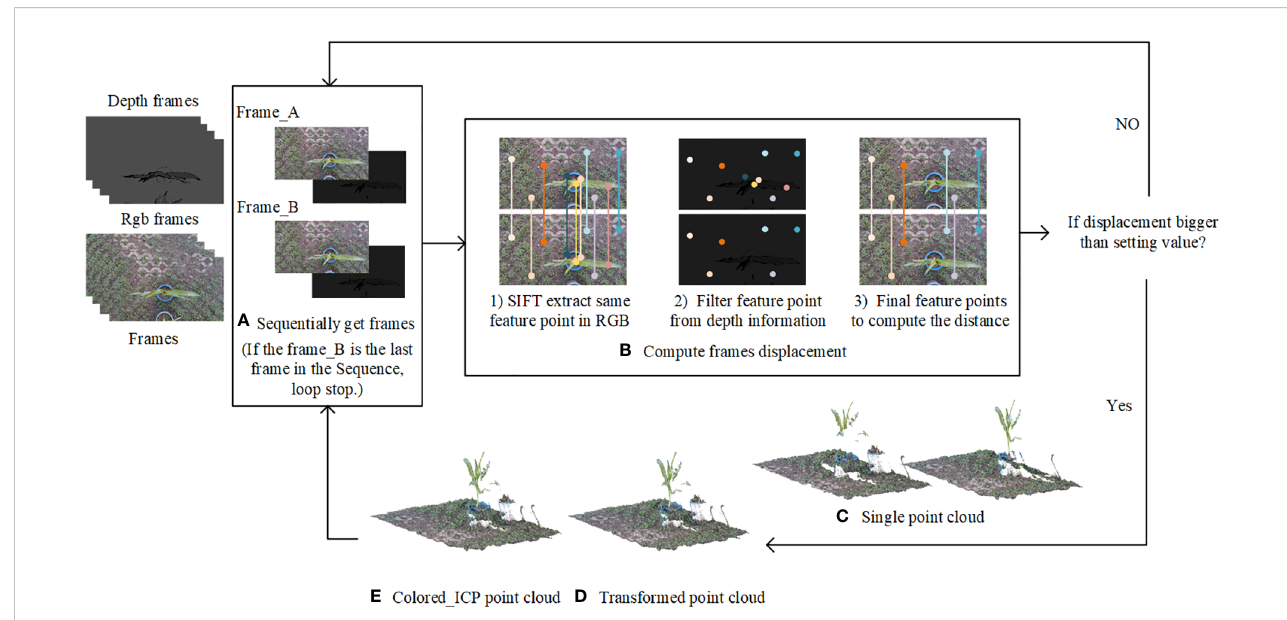
FIGURE 3 Process of crop row point cloud matching.